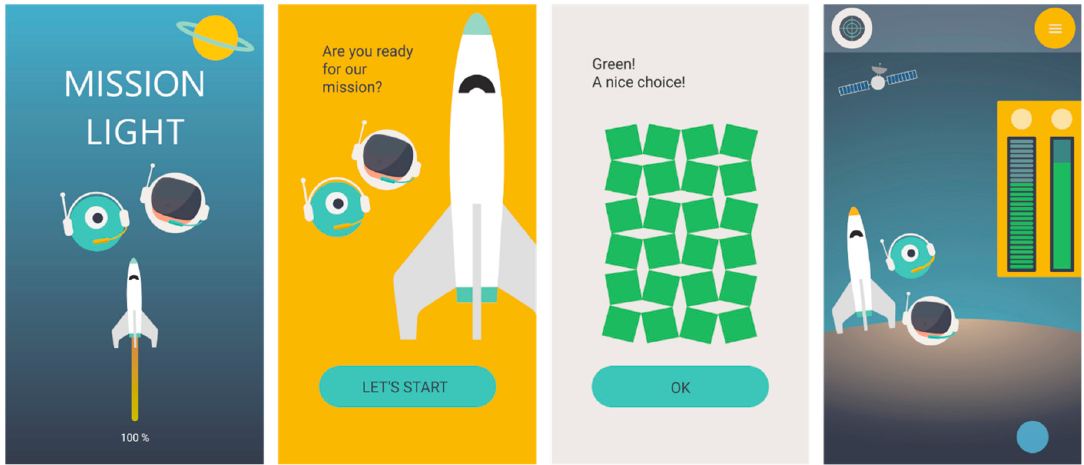
Figure 6. Screens of the click-through prototype application displaying the start screen (left), introduction and onboarding process (middle two) and home screen (right).